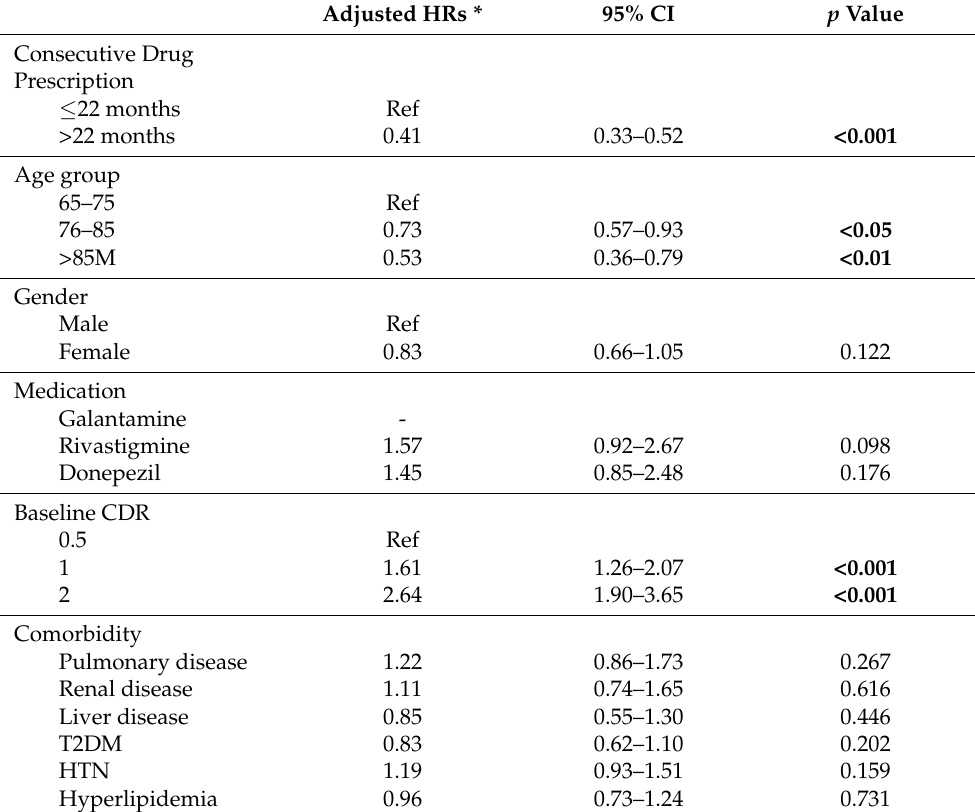
Table 2. Cox proportional hazards model for rapid decline within 2 years in patients with Alzheimer’s